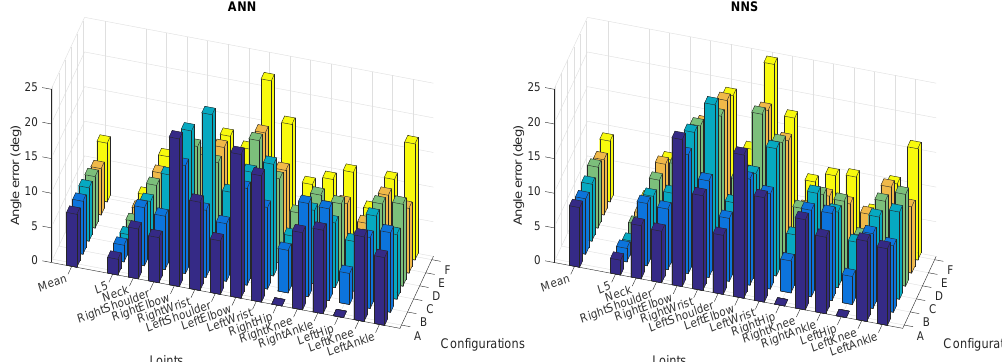
Figure 5. Mean (over all six subjects) joint angle errors for different configurations (as described in Figure 3) are shown on the left-side of both bar plots (ANN on the left and NNS on the right). Individual mean (over all six subjects) joint angle errors are shown on the right-side of both bar plots. A selection of joints is shown in both bar plots for readability. The different spine joints are not shown, because the joint angle errors are similar to the L5 joint. Similarly, extra shoulder/foot joints are not presented because the magnitude of the error is similar to that of the shoulder and ankle joints